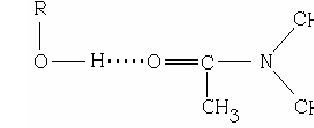
Figure 1. Hydrogen bond between alcohols and